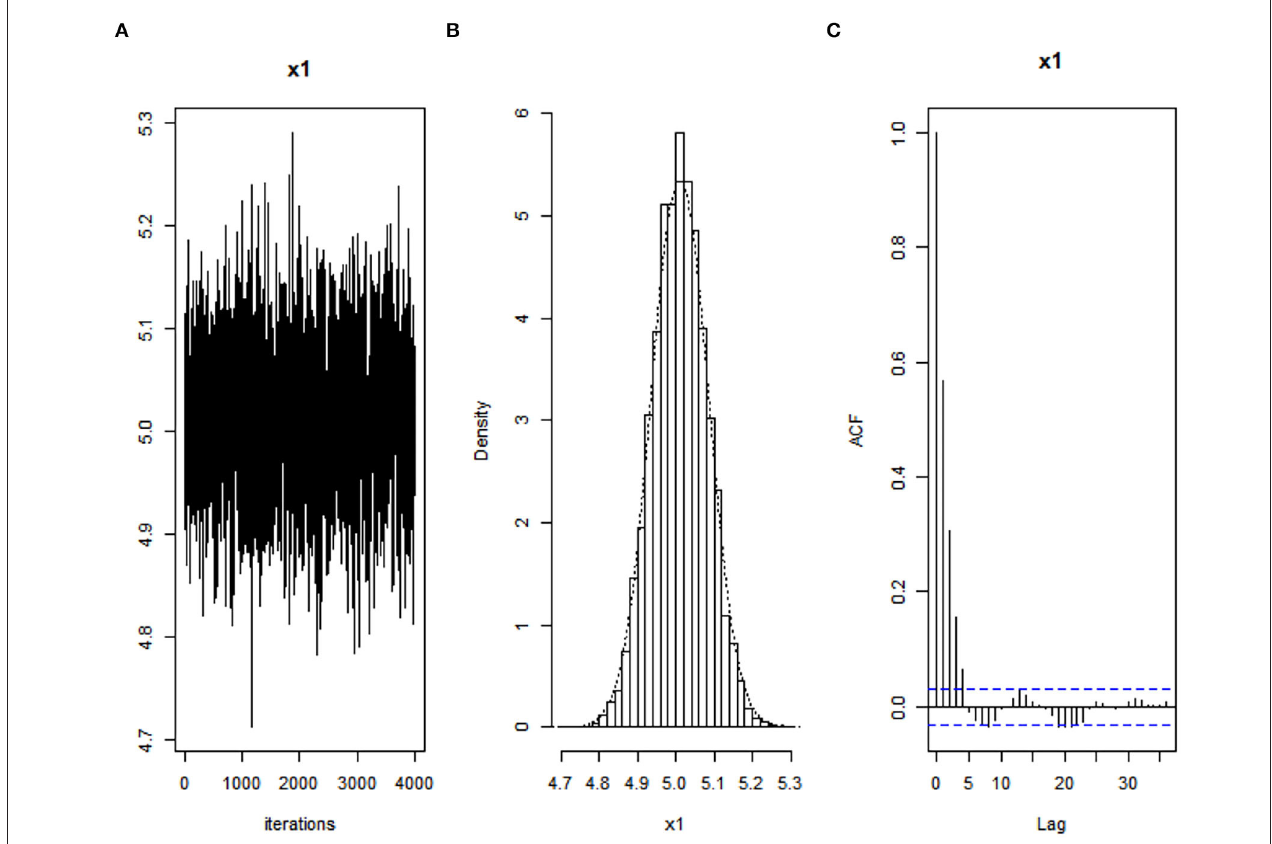
FIGURE 2 | Convergence diagnostics of parameter ˆ β 1 for autocorrelated error when τ density plot, and (C) autocorrelation